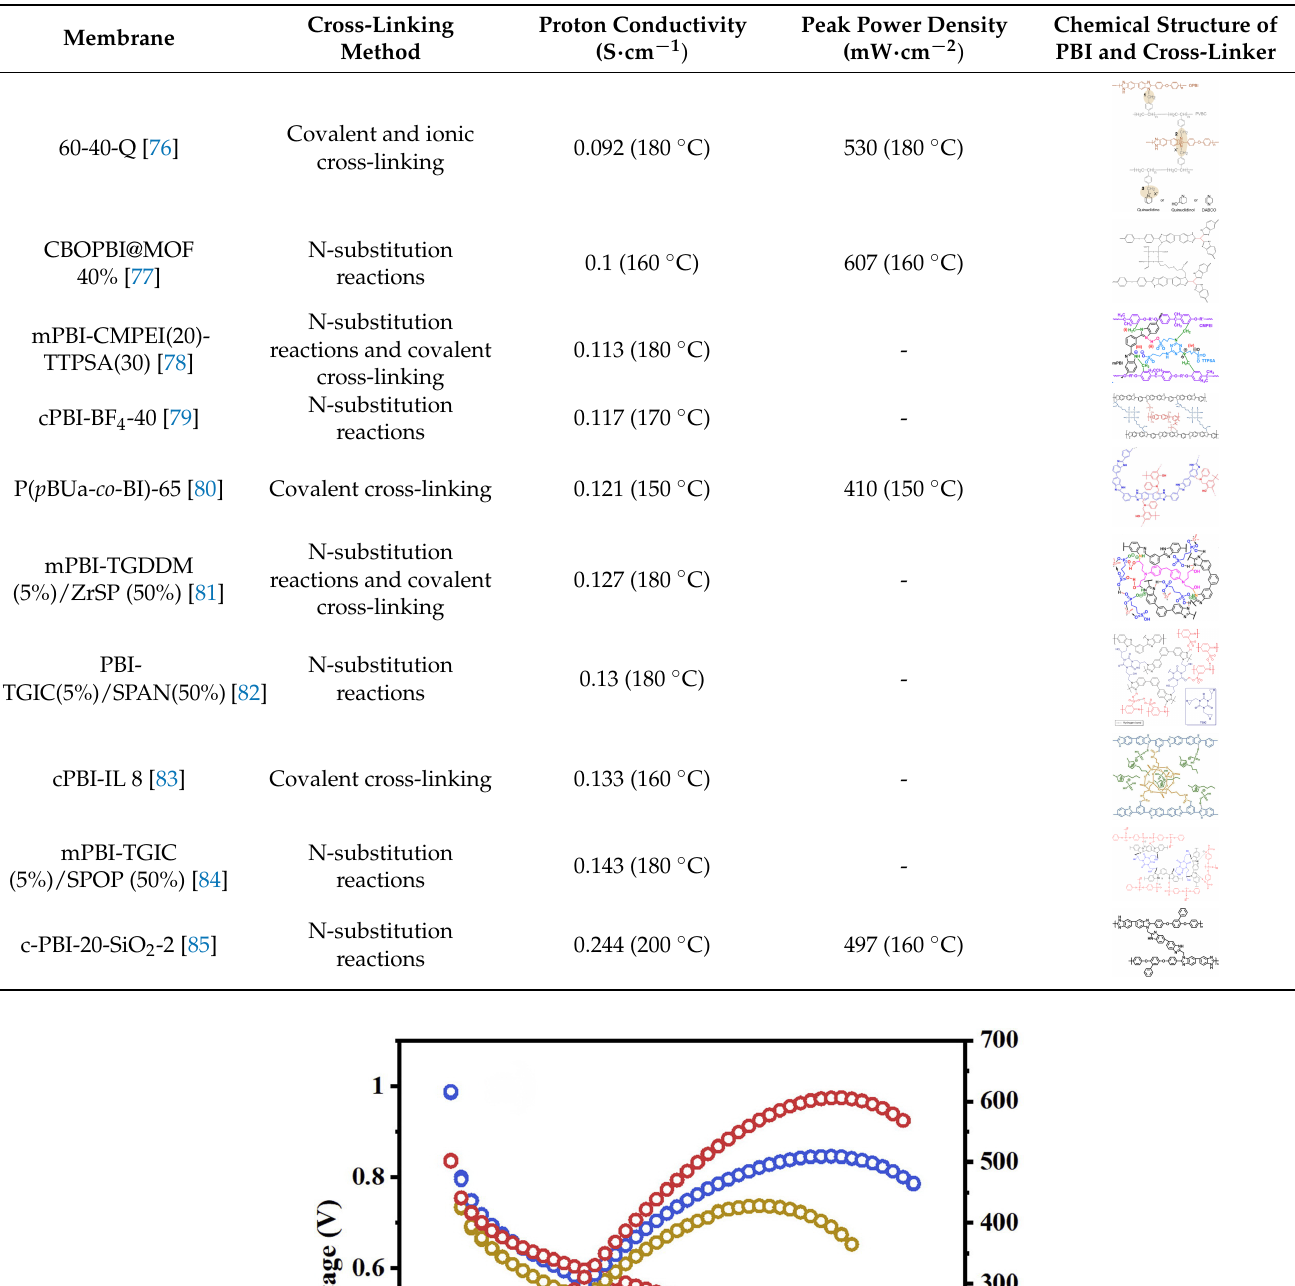
Table 3. Some cross-linked polybenzimidazole-based composite and blend membranes.